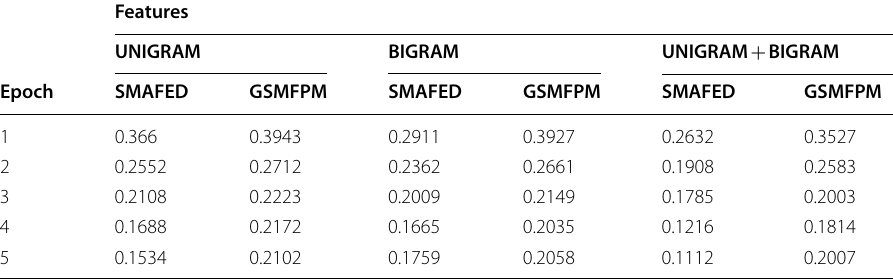
Table 13 Multi-layer perceptron cross-entropy loss function for GSMFPM and SMAFED on Naija- tweets dataset